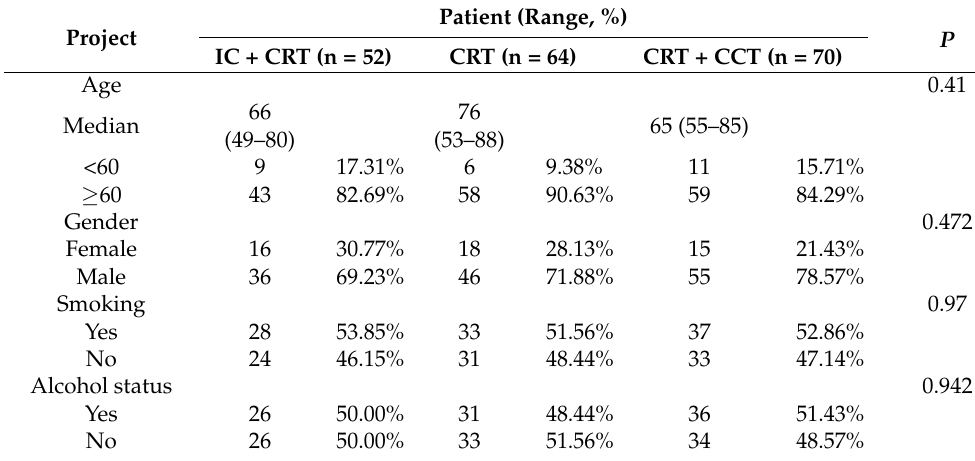
Table 1. Basic characteristics of IC + CRT, CRT, and CRT + CCT